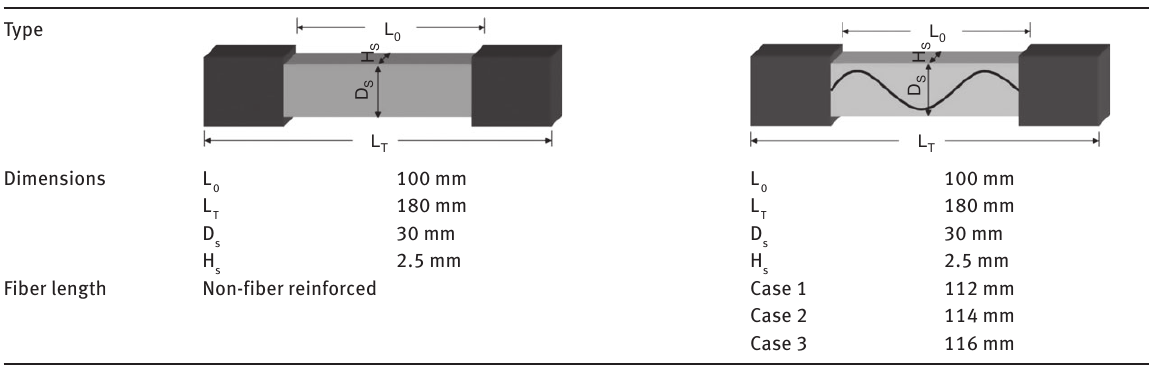
Table 1 Dimensions of the pure silicone rubber specimen and the fiber-reinforced silicone rubber